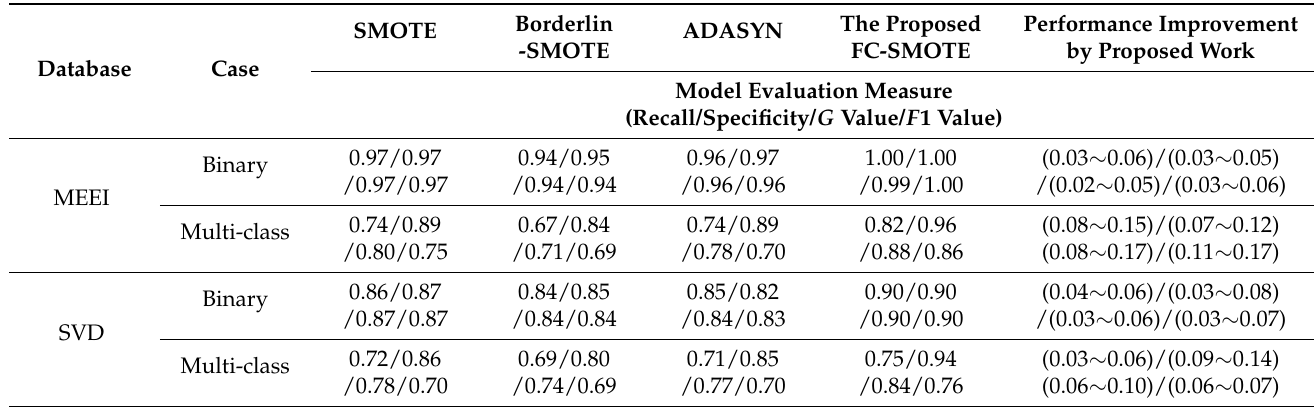
Table 13. Performance comparison between SMOTE, Borderline-SMOTE, ADASYN, and the proposed FC-SMOTE in the MEEI